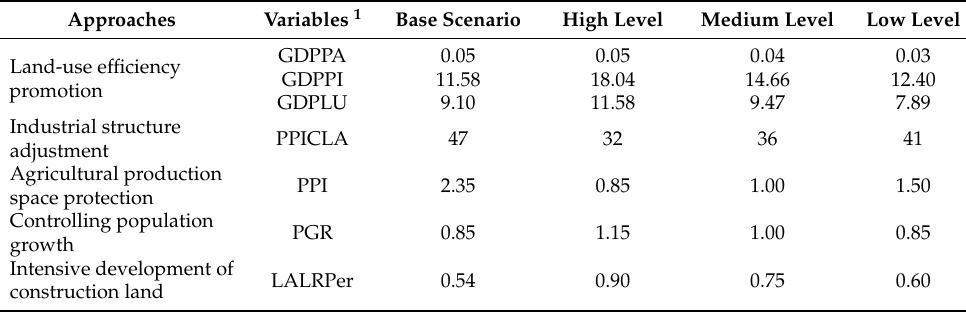
Table 7. Base scenario and parameter settings at different